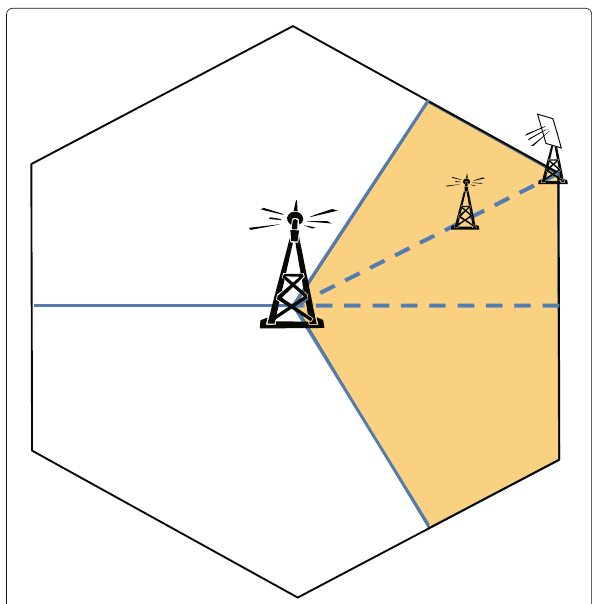
Fig. 3 Three-sector cell